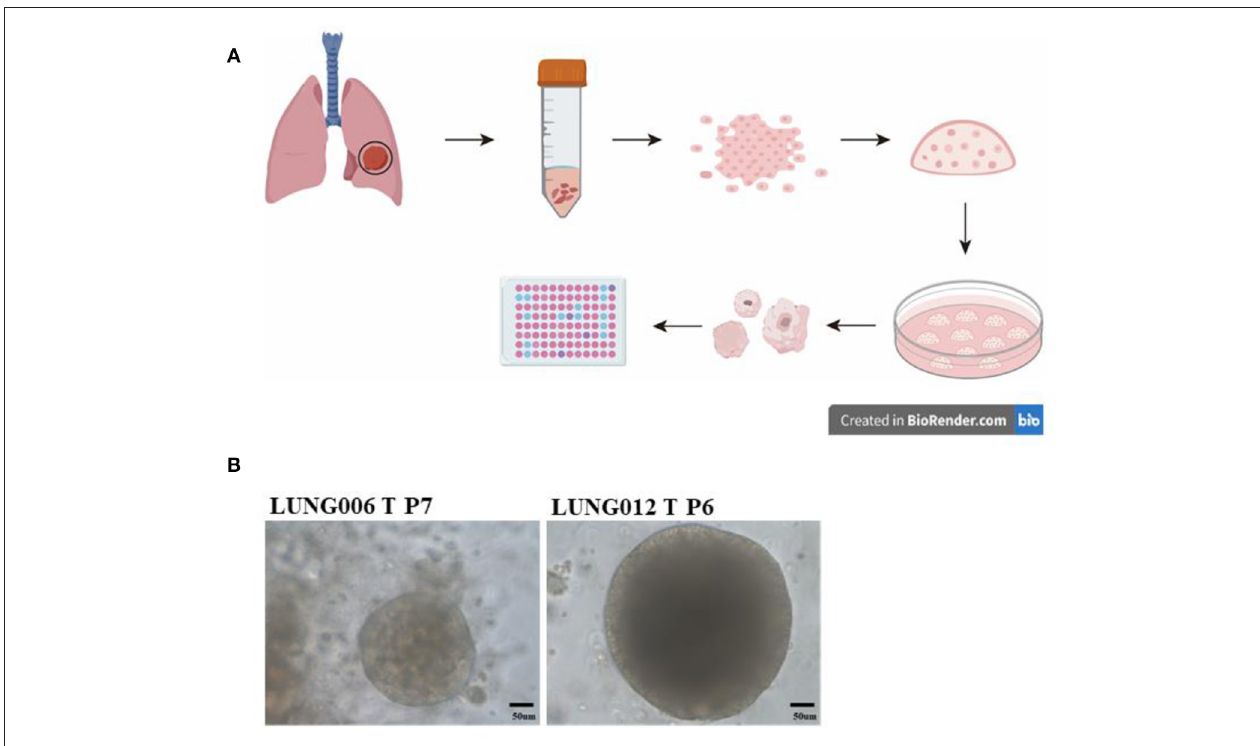
FIGURE 2 | Drug testing via patient-derived organoids models: (A) Collecting the lung cancer specimens from patients during surgery, digesting the tissue and seeding cells in growth factors reduced Matrigel; dome culturing in culture medium; organoids culturing and passage; preforming Cell Titer-Glo Luminescent cell viability assay for drug testing. (B) Representative image of long-term culture lung cancer organoids (more than five passages) in our